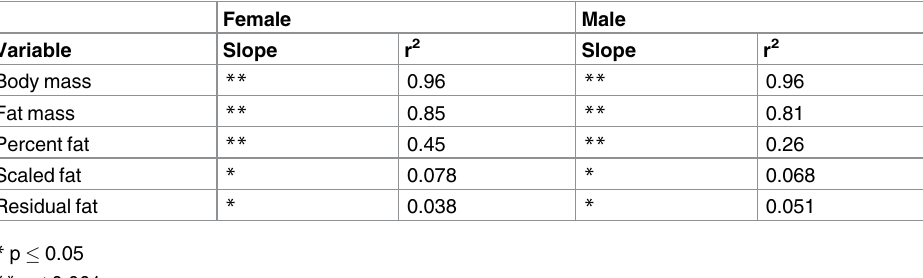
Table 3. Relationships between body length and mass, fat, and true body condition measuresfor male and female Burmese pythons. We estimated the probabilitythat the slope is not zero (i.e., p (cid:20) 0.05) and calculatedthe r 2 values from SMA regressions of log-transformed body mass and log-transformed wet-fat mass on log-transformed snout-vent length(SVL) and from OLS regressions of percent fat, scaled fat, and residual fat on log-transformed SVL. Ideally, measuresof true body conditionwill have no relationship with body length (i.e., percent fat, scaled fat, and residual fat should have non-significant regressionslopes and r 2 values of zero), but each of them do. These results are visualizedin Fig 1.